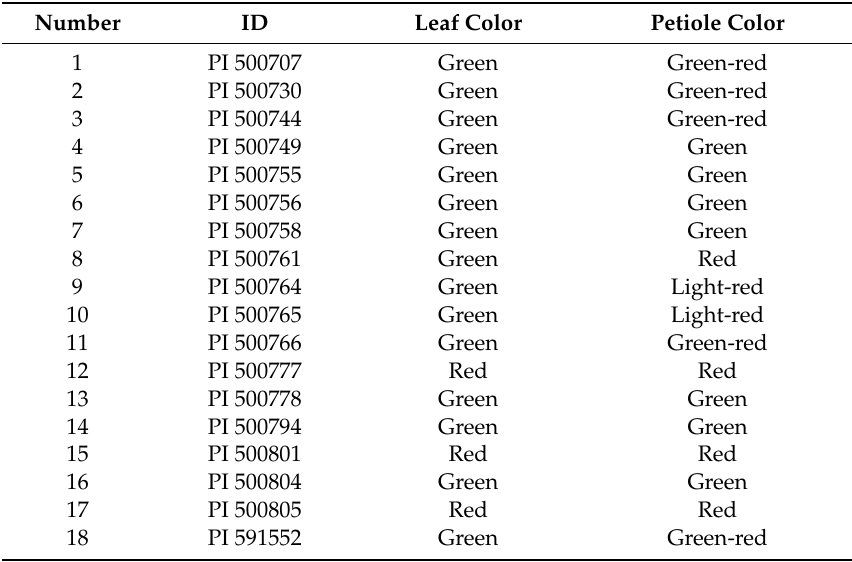
Figure 1. Leaf color of the 18 different H. acetosella accessions used in this study. Table 1. Leaf and petiole color of the 18 different H. acetosella accessions used in this study.